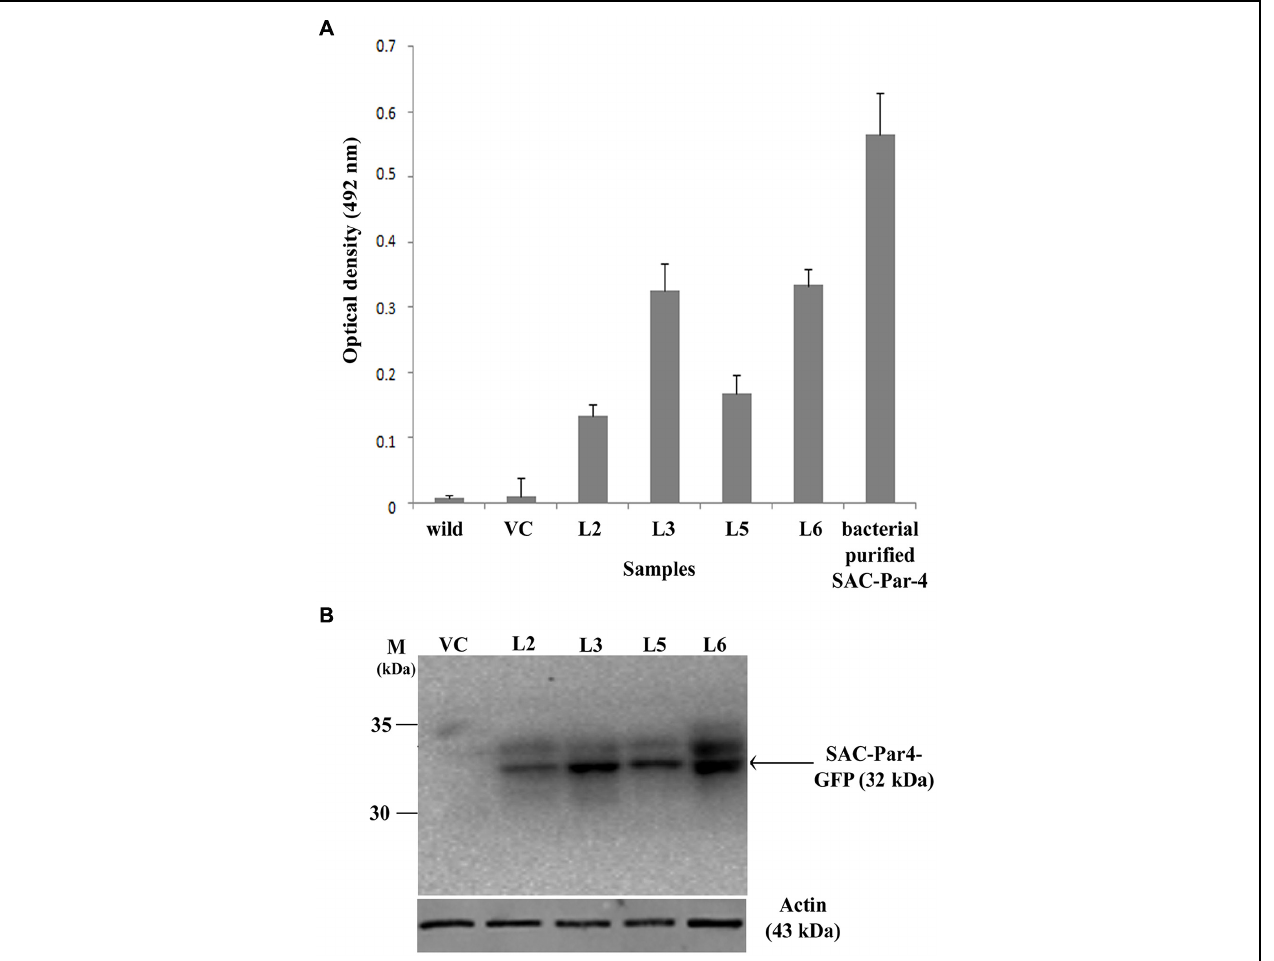
FIGURE 4 | Evaluation of recombinant SAC-Par-4-GFP accumulation. (A) ELISA analysis of recombinant SAC-Par-4-GFP accumulation from L2, L3, L5, and L6 transgenic plants along with wild-type and VC plant. Values are the average of three independent experiments. Bars indicate standard deviations; (B) Detection of SAC-Par-4-GFP protein on the Western blot from different transgenic lines, indicated by arrow. Numbers on the left indicate the size of protein standard. β -actin was used as loading